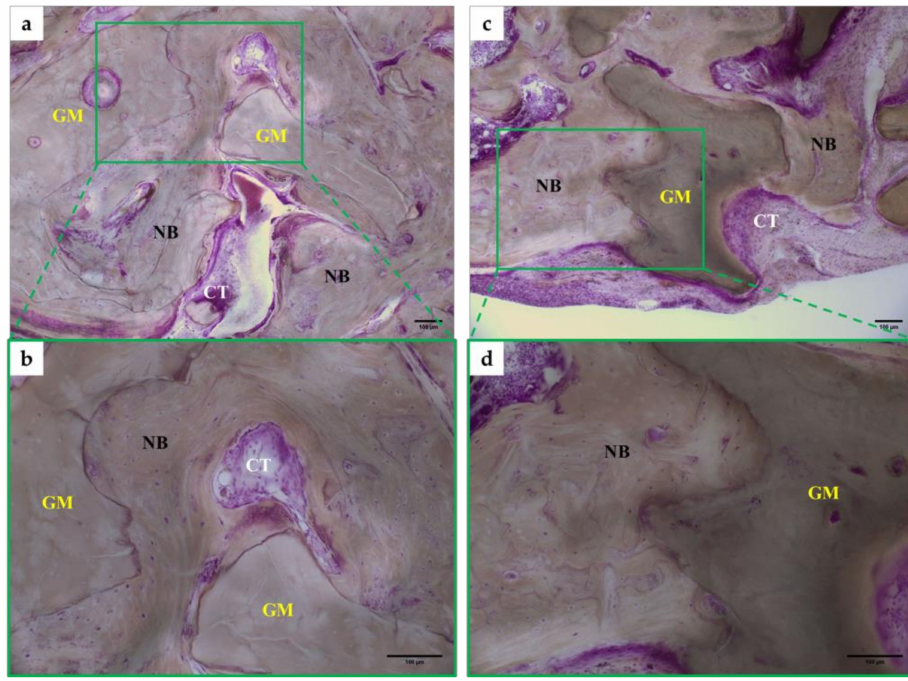
Figure 6. Image of Histomorphormetric analysis in a rat calvarial at 12 weeks. ( a , b ) Bio-Oss ® at 12 weeks, ( c , d ) Ti-oss ® at 12 weeks. All groups were H&E-stained and observed at × 100 and × 200 with an optical microscope. NG: New Bone, GM; Graft Material, CT; Connective